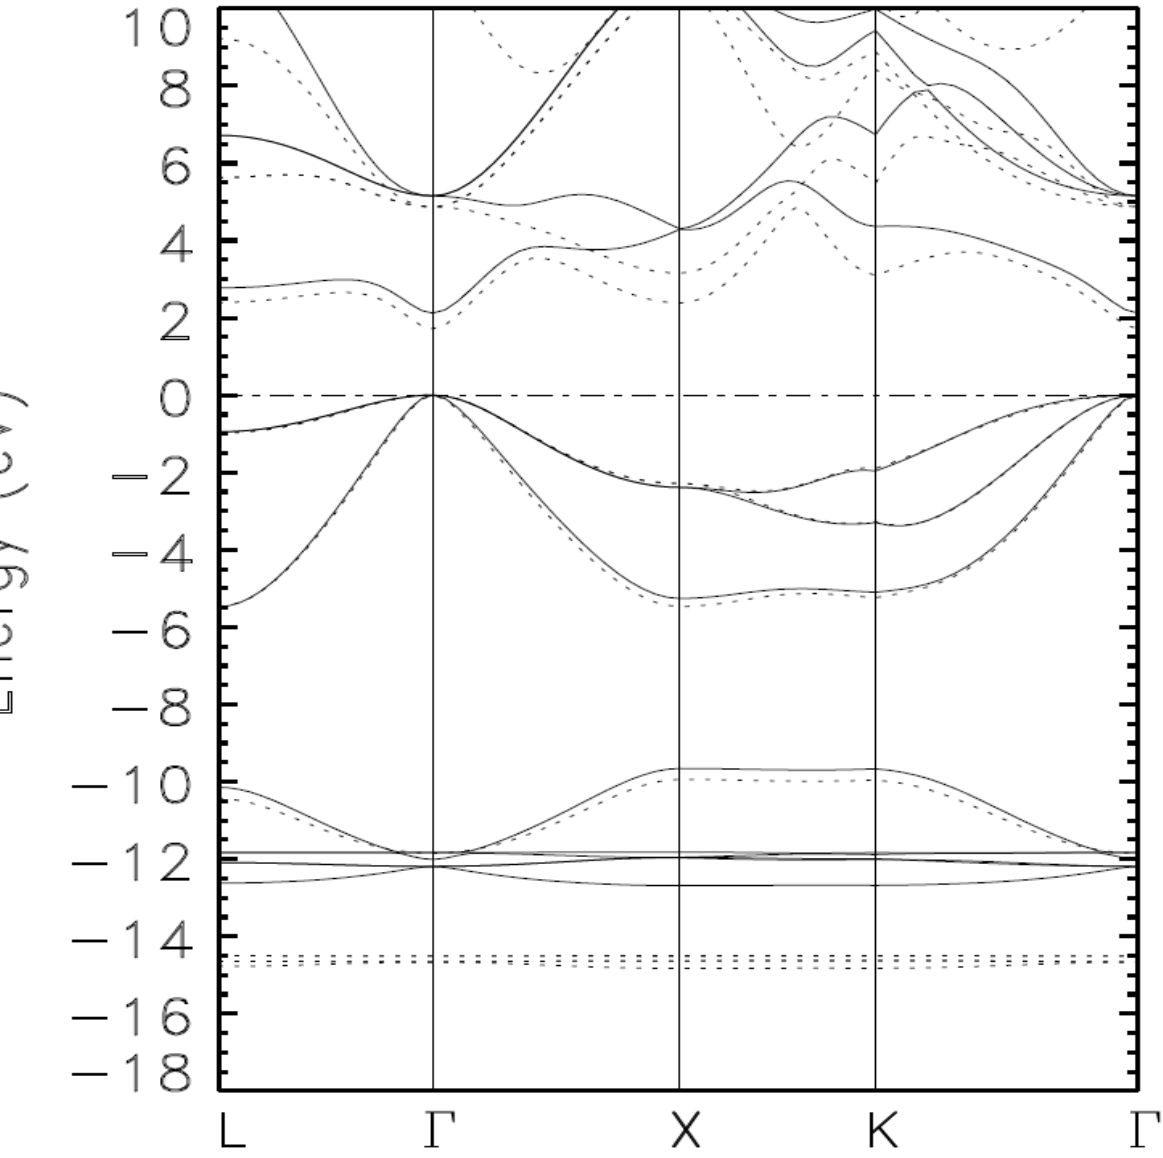
Figure 1. Calculated band structure of zinc blende indium arsenide (zb-InAS) as obtained by the BZW method from calculations I (full line) and II (dashed line). The drastic change in the valence bands, signified by the dashed lines below − 14 eV, indicates that the basis set for Calculation I was far from complete for the description of the material.